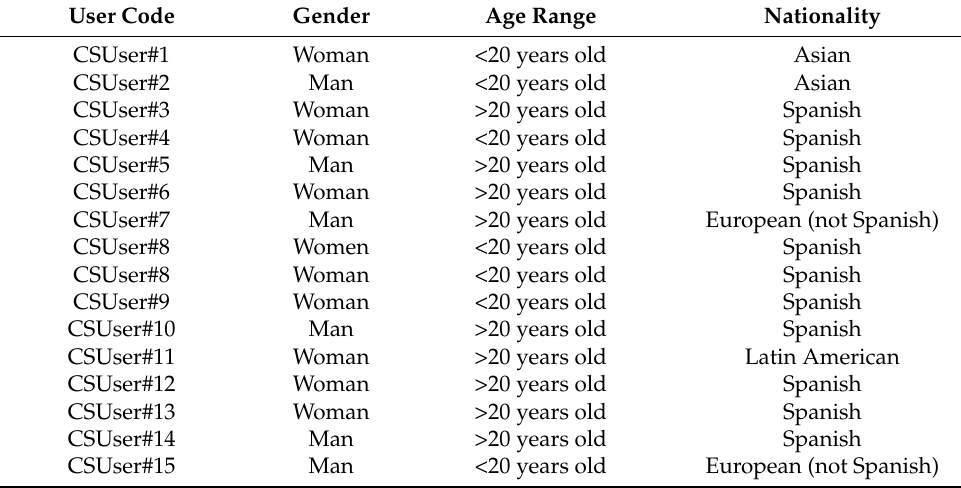
Table 1. Profile of car sharing